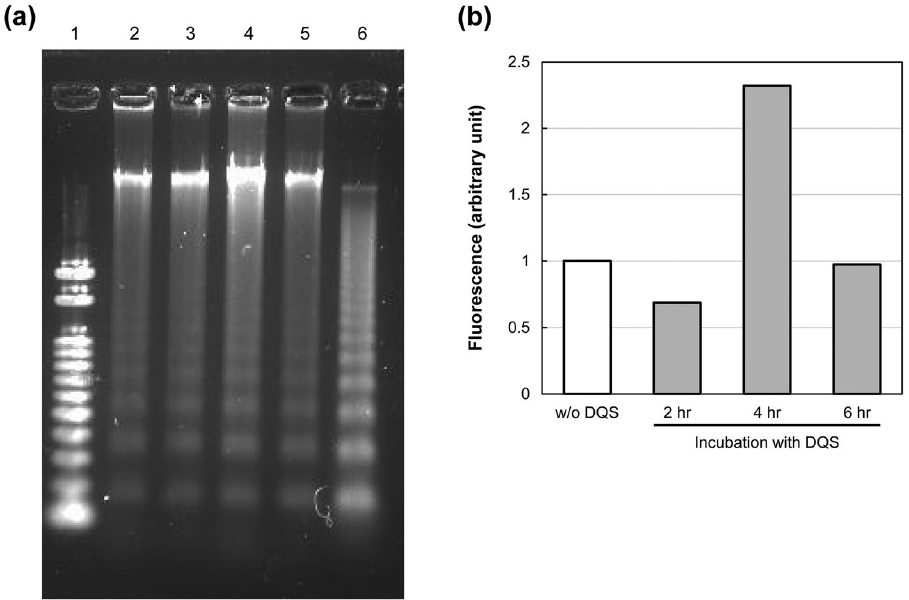
Figure 3. Analysis of DNA fragments isolated from meibocytes treated with DQS. ( a ) Representative image of agarose gel electrophoresis. Lane 1, DNA size marker (100 bp); lane 2, without DQS; lanes 3–5, treated with DQS (0.85%) for 2, 4 and 6 h, respectively; lane 6, positive apoptotic control. ( b ) Quantification of the DNA fragments. Each intensity of fluorescence is represented as ratio of control (w/o